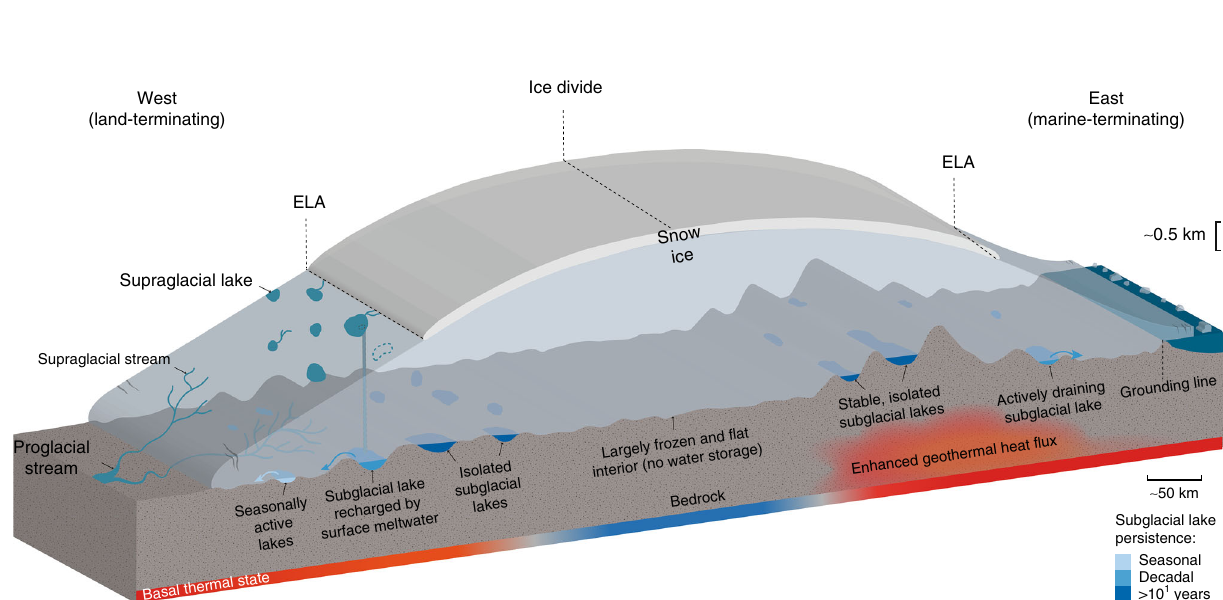
Fig. 6 Conceptual model of Greenland ice sheet hydrological system, illustrating supraglacial and subglacial features. Subglacial lakes are colour-coded according to lake persistence, those that are less distinct and could represent shallow water lenses or patches of saturated sediment are coloured brown. Estimated basal thermal state is represented by the red to blue colour bar, with red being likely thawed, white being uncertain regions, and blue being likely frozen 1 . In the ice sheet interior, the ice is mostly frozen to the bed and the basal topography is fl at, prohibiting water storage and subglacial lake formation. Above the equilibrium line altitude (ELA) but away from ice divides, where the bed is predicted to comprise a heterogeneous patchwork of frozen and warm-bedded conditions, subglacial lakes are relatively common but stable features. Around the ELA, subglacial lakes are hydrologically active and recharged seasonally by inputs of surface water. Finally, relatively numerous small subglacial lakes that drain on seasonal timescales when ef fi cient subglacial networks develop during the melt season likely exist in the ablation